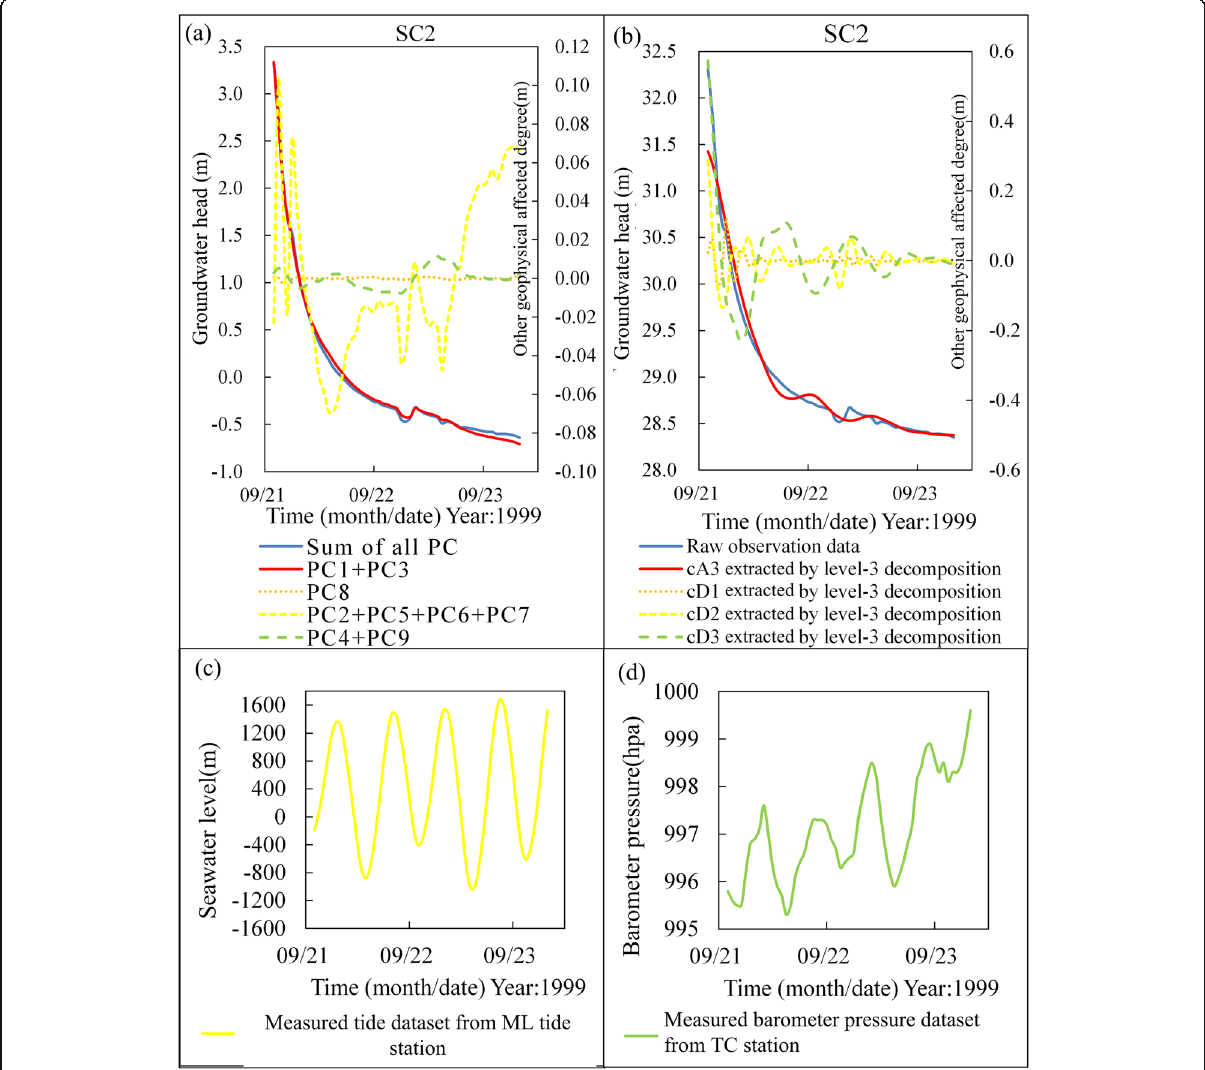
Fig. 17 The decomposed post-seismic measured groundwater heads for zone SC2 by different filtration analysis methods: a PCA and b level-3 wavelet transform comparing to the measured geophysical data from c ML tide station and d TC barometer station. (Note: The coordinates for the solid lines are on the left, whereas the coordinates for the dotted lines are on the